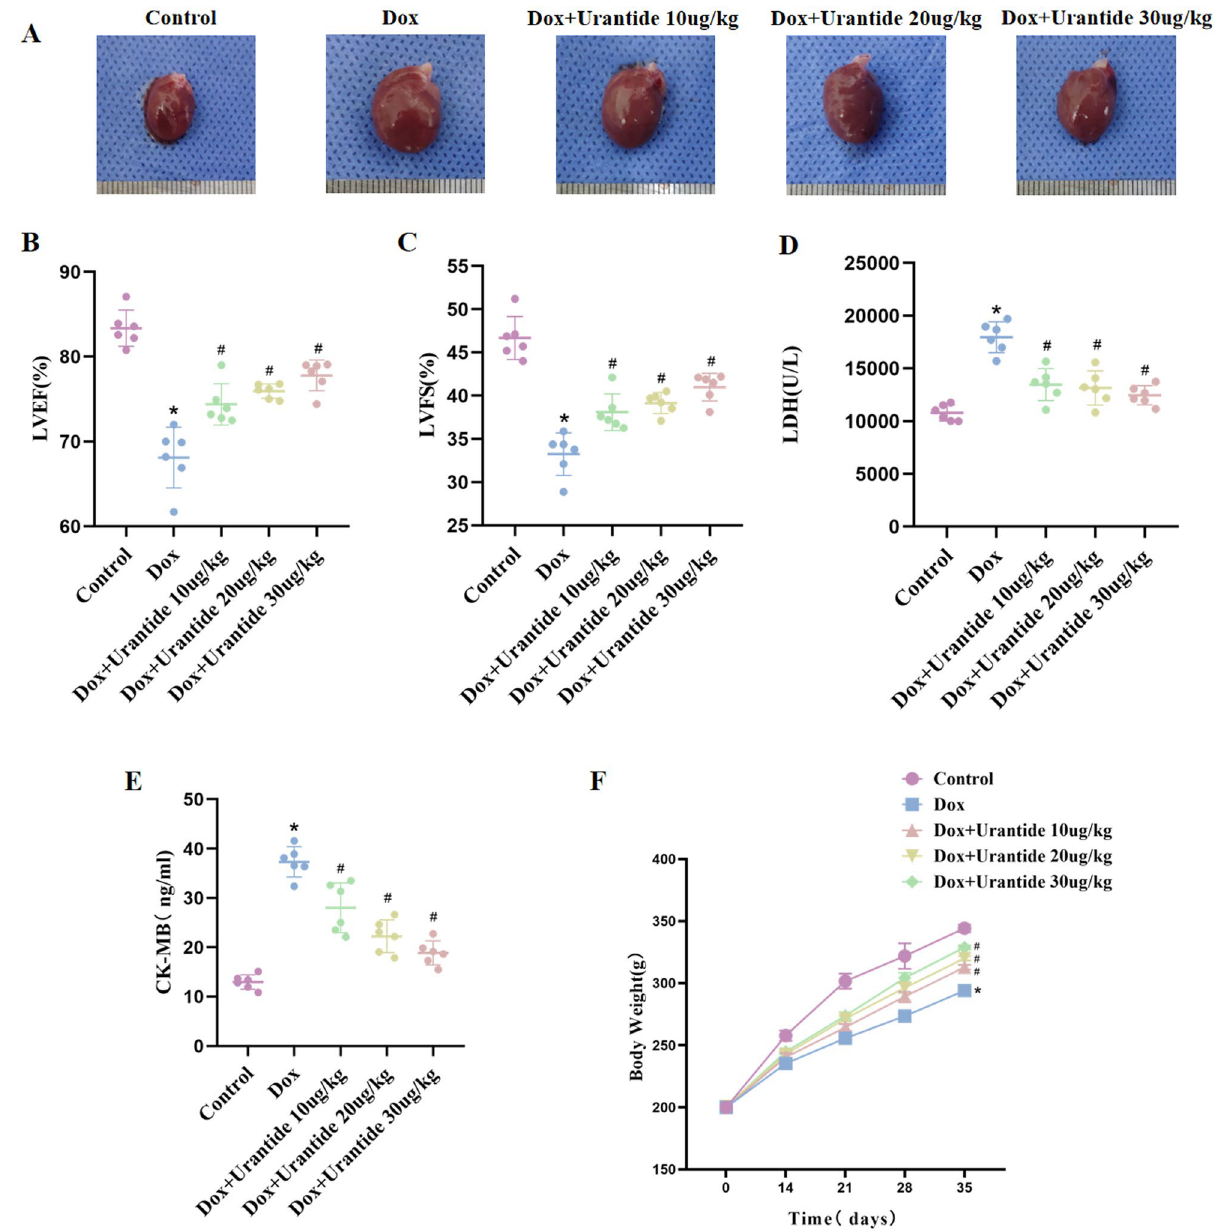
Figure 2. Urantide improves DOX-induced cardiac damage in vivo. ( A ) Representative images of global appearance of the heart in different groups. Results of LVEF ( B ) and LVFS ( C ) in the five groups (n = 6 per group). Enzyme ‐ linked immunosorbent assay was used on serum from rats to determine the expression of LDH ( D ) and CK-MB ( E ). ( F ) Average body weight change in 5 wk in rats from five groups (n = 6 per group). *P < 0.05, vs. the control; # P < 0.05 vs. the DOX